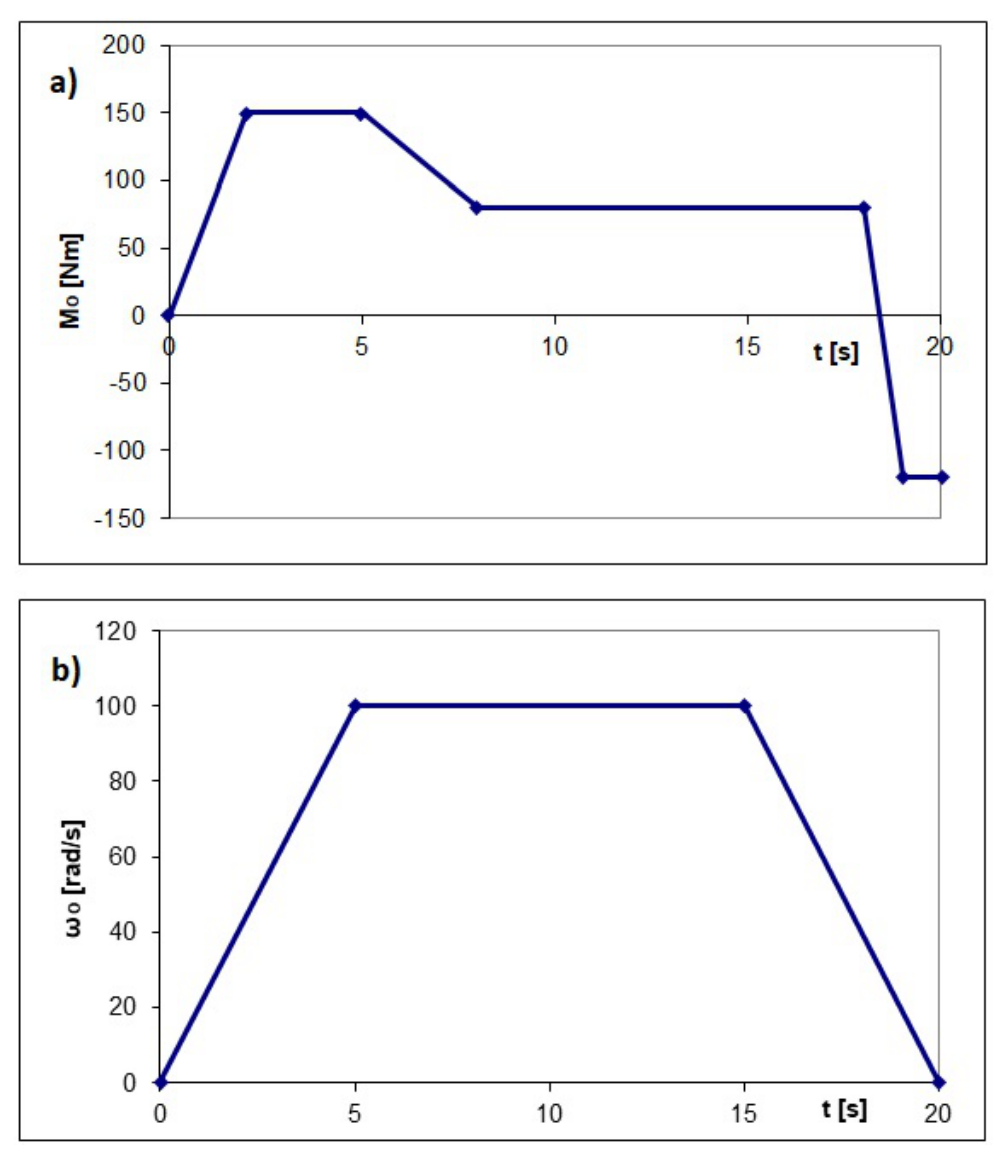
Figure 12. Load I: ( a ) M o : load torque; ( b ) ω o : angular velocity of